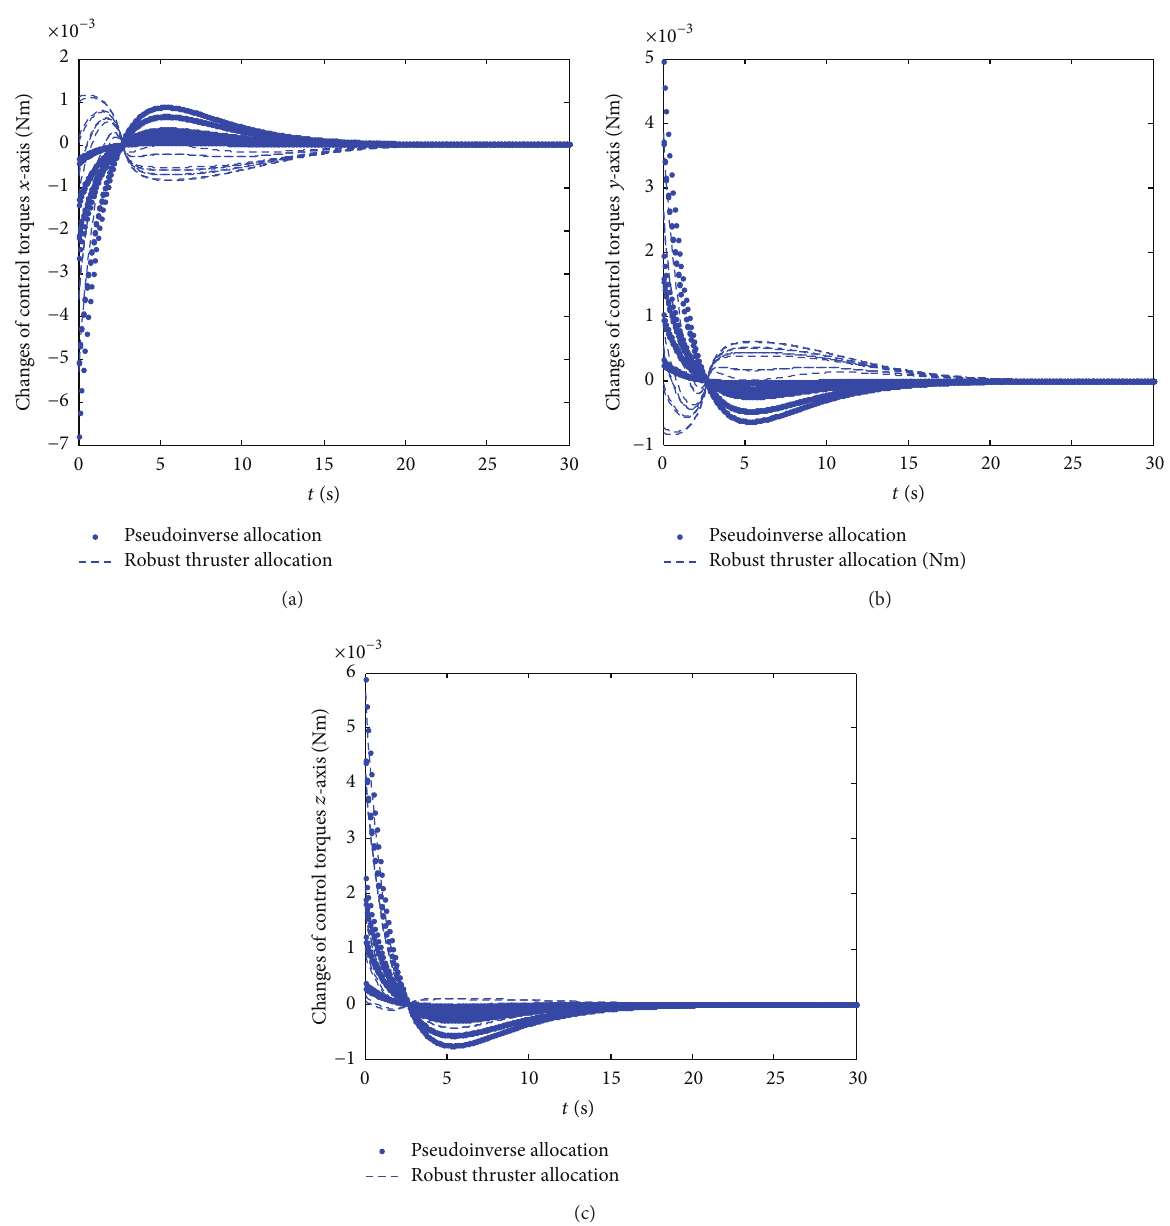
Figure 7: The curves of torque distribution deviation when the control efficiency matrix is with the uncertainty of 5%.